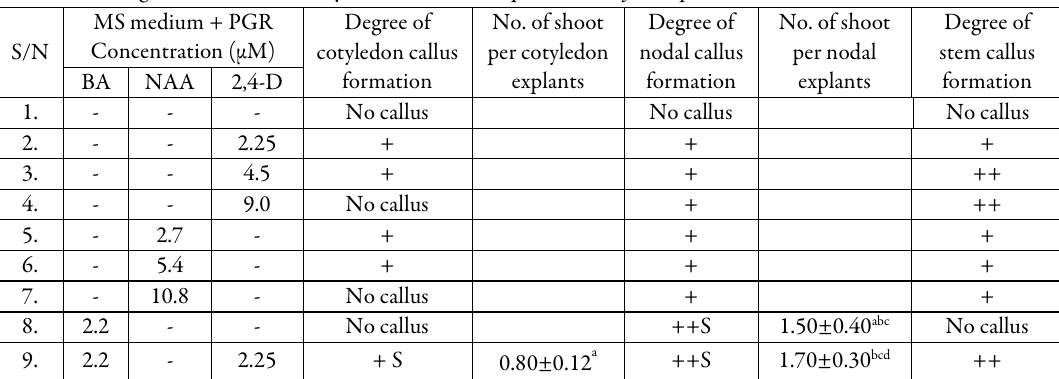
Table 3. The effects of various concentration of NAA, 2, 4-D alone or each separately combined with BA on caulogenesis from stem, cotyledon and nodal explants of E.